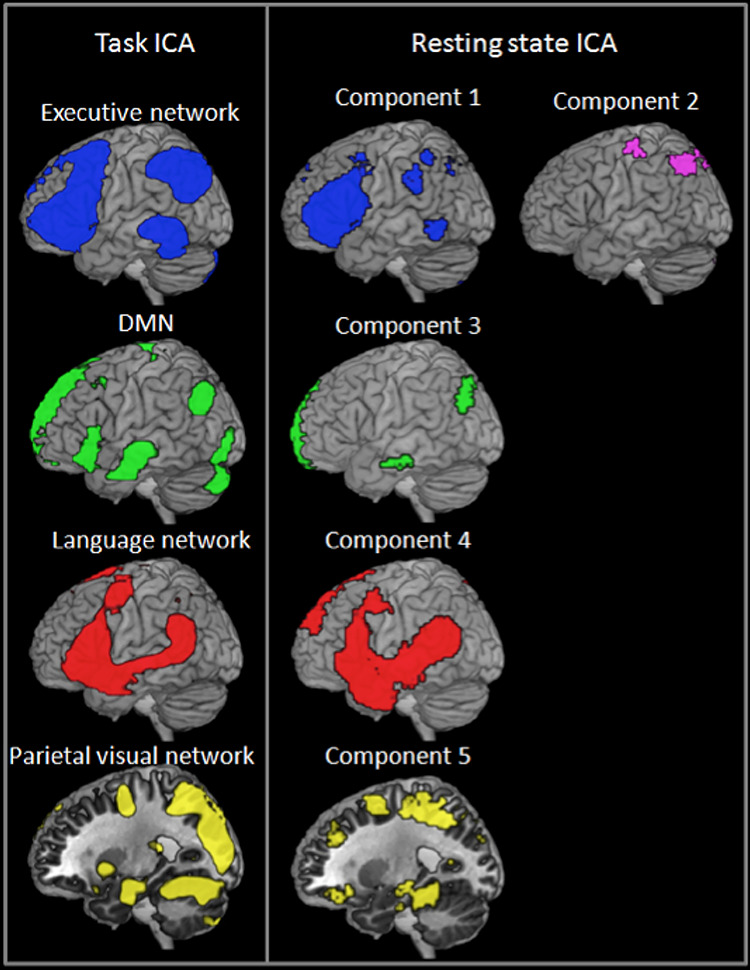
The correspondence between the task ICA and resting state ICA analyses.